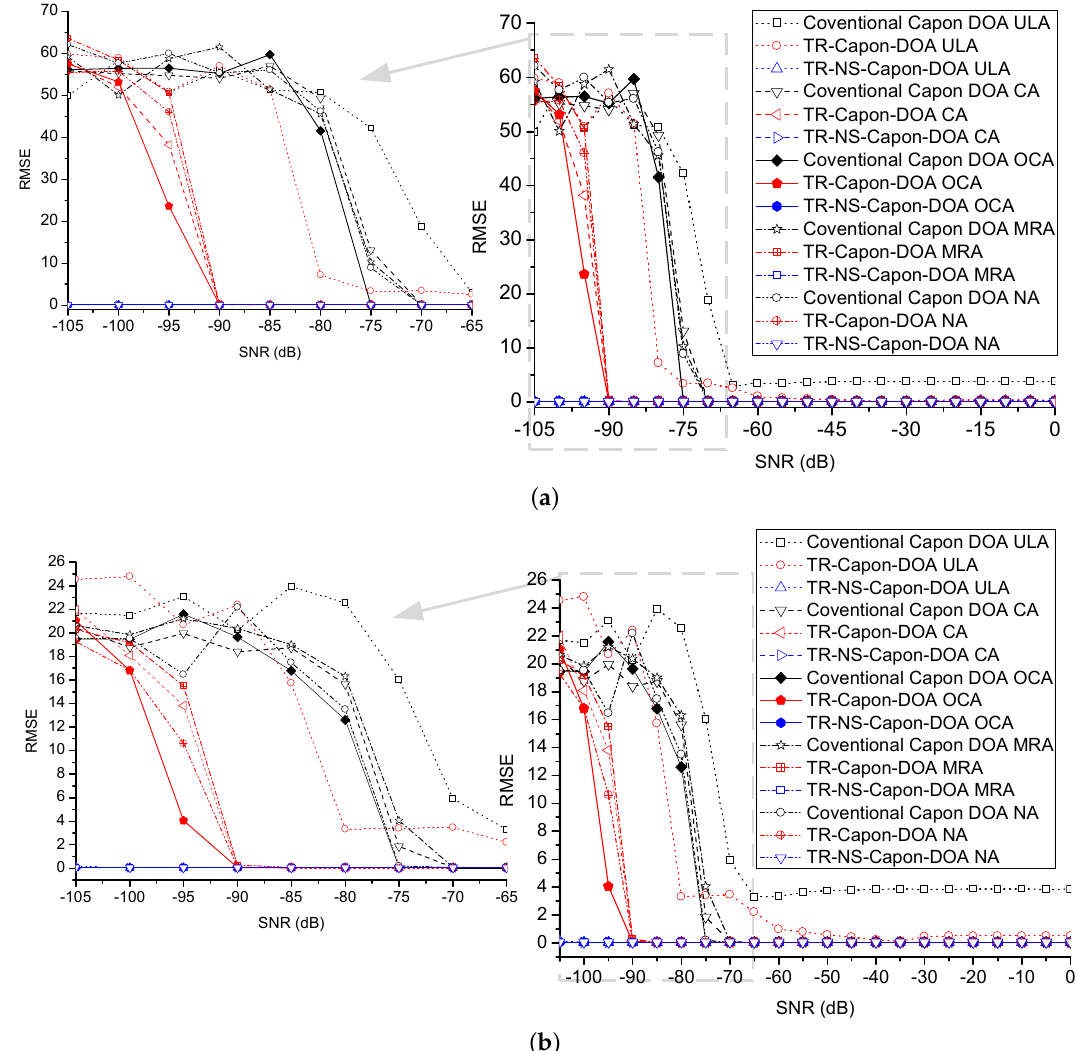
Figure 17. RMSE versus SNR for conventional Capon DOA, TR-Capon-DOA and TR-NS-Capon-DOA algorithms with the configurations of ULA, CA, OCA MRA and NA under the condition of LFM used as ES ( a ) DOA = 32 ◦ ( b ) DOA = 40 ◦